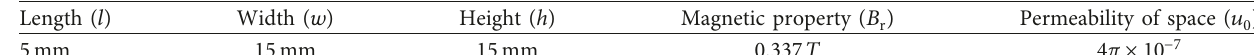
Figure 3: The calculation diagram of permanent magnet repulsive force. (a) The repulsive force of two permanent magnets; (b) the repulsive force of the magnet tuned mass Table 1: Material parameters of the magnet.